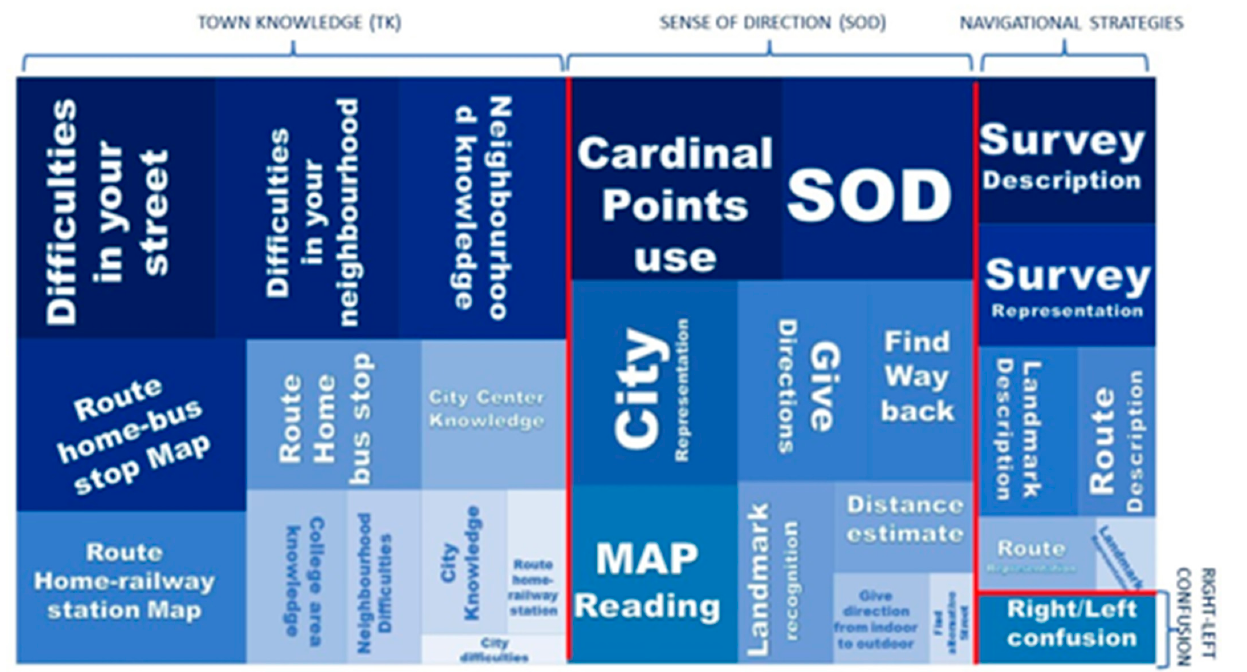
Figure 2. The larger the area and the darker the colour, the greater the difficulty that characterizes DTD in the different aspects of spatial navigation investigated.